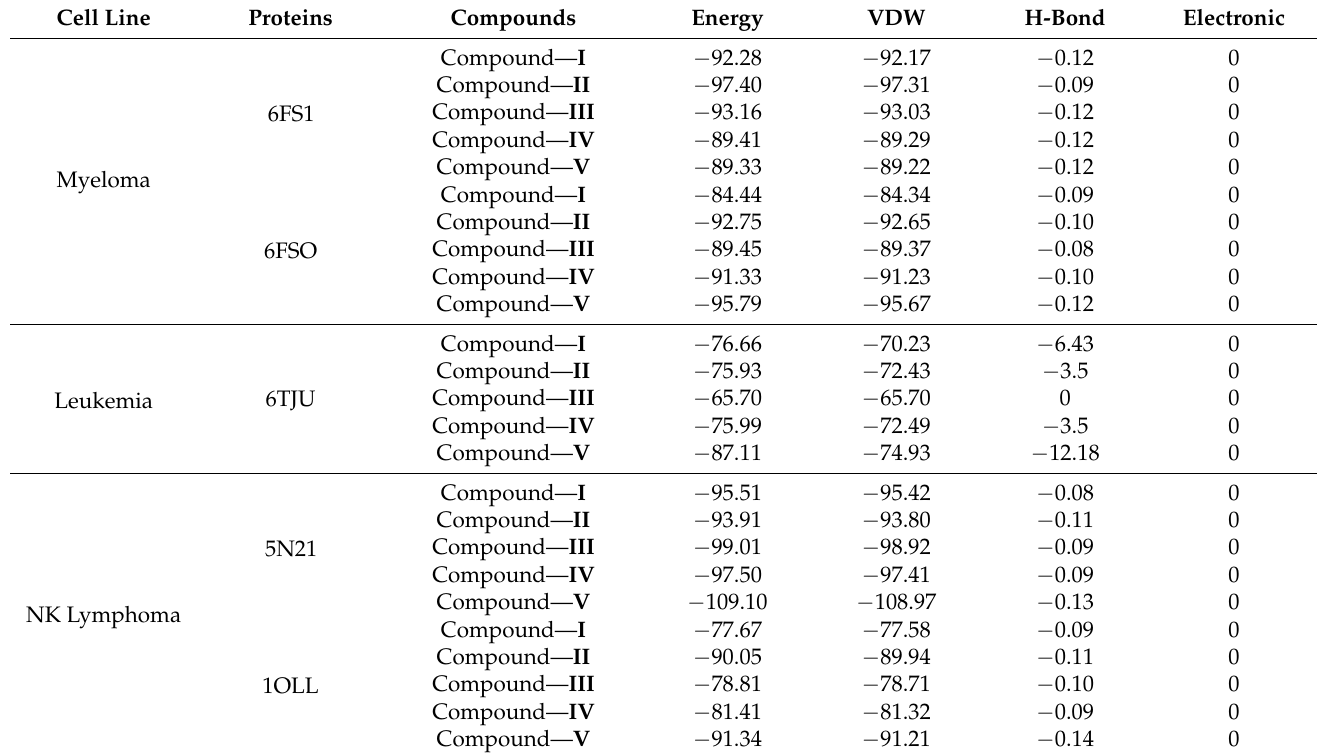
Table 1. Molecular docking calculations of compounds ( I – V ) with the different proteins (6FS1, 6FSO, 6TJU, 5N21, and